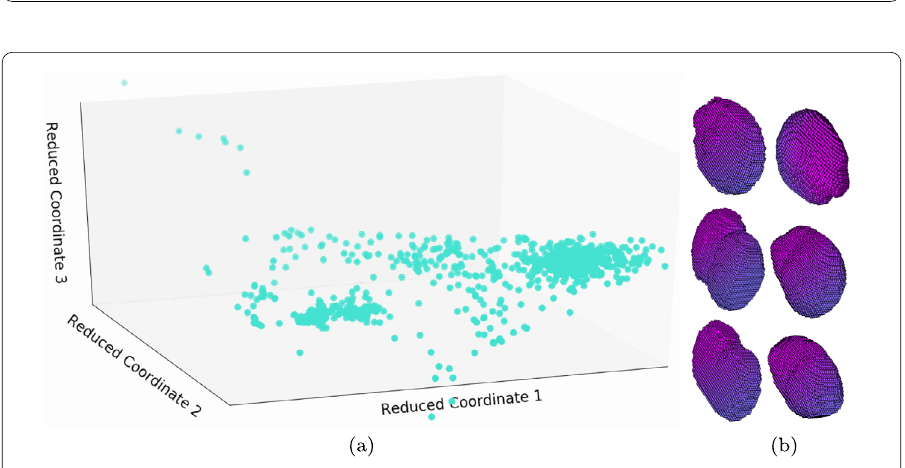
Figure 14 ( a ) Shapes in the three first singular components space. ( b ) Examples of shapes in the three first singular components space